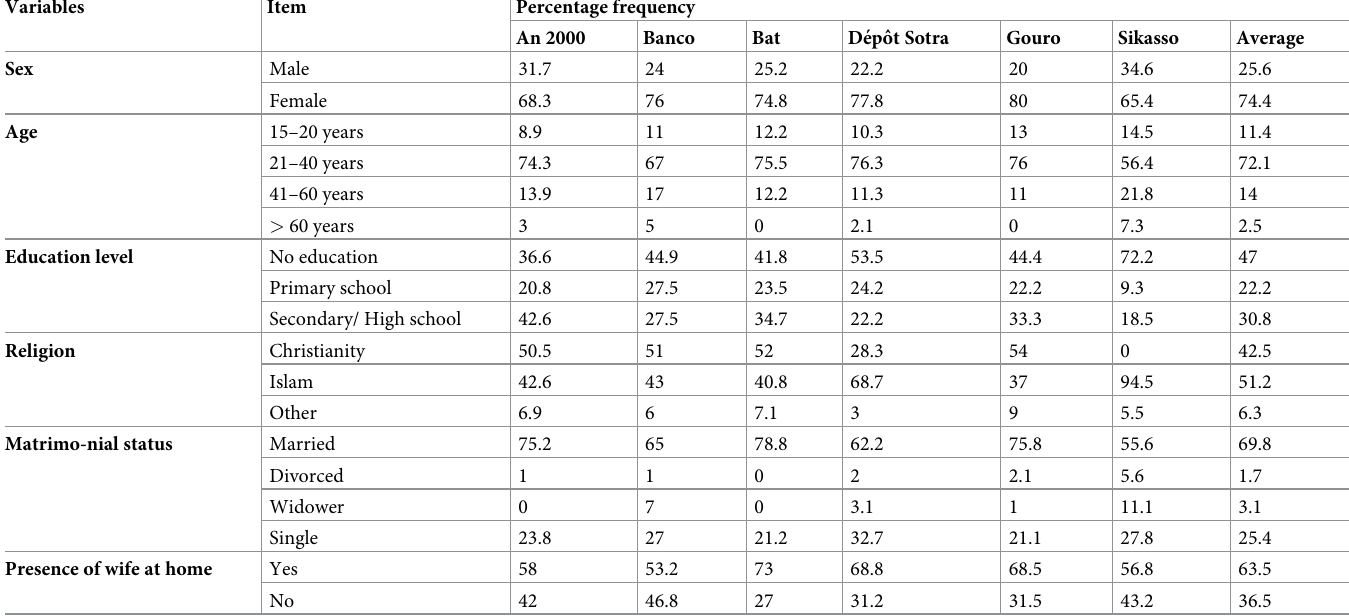
Table 2. Socio-demographic characteristics of the respondents in the different settlements.